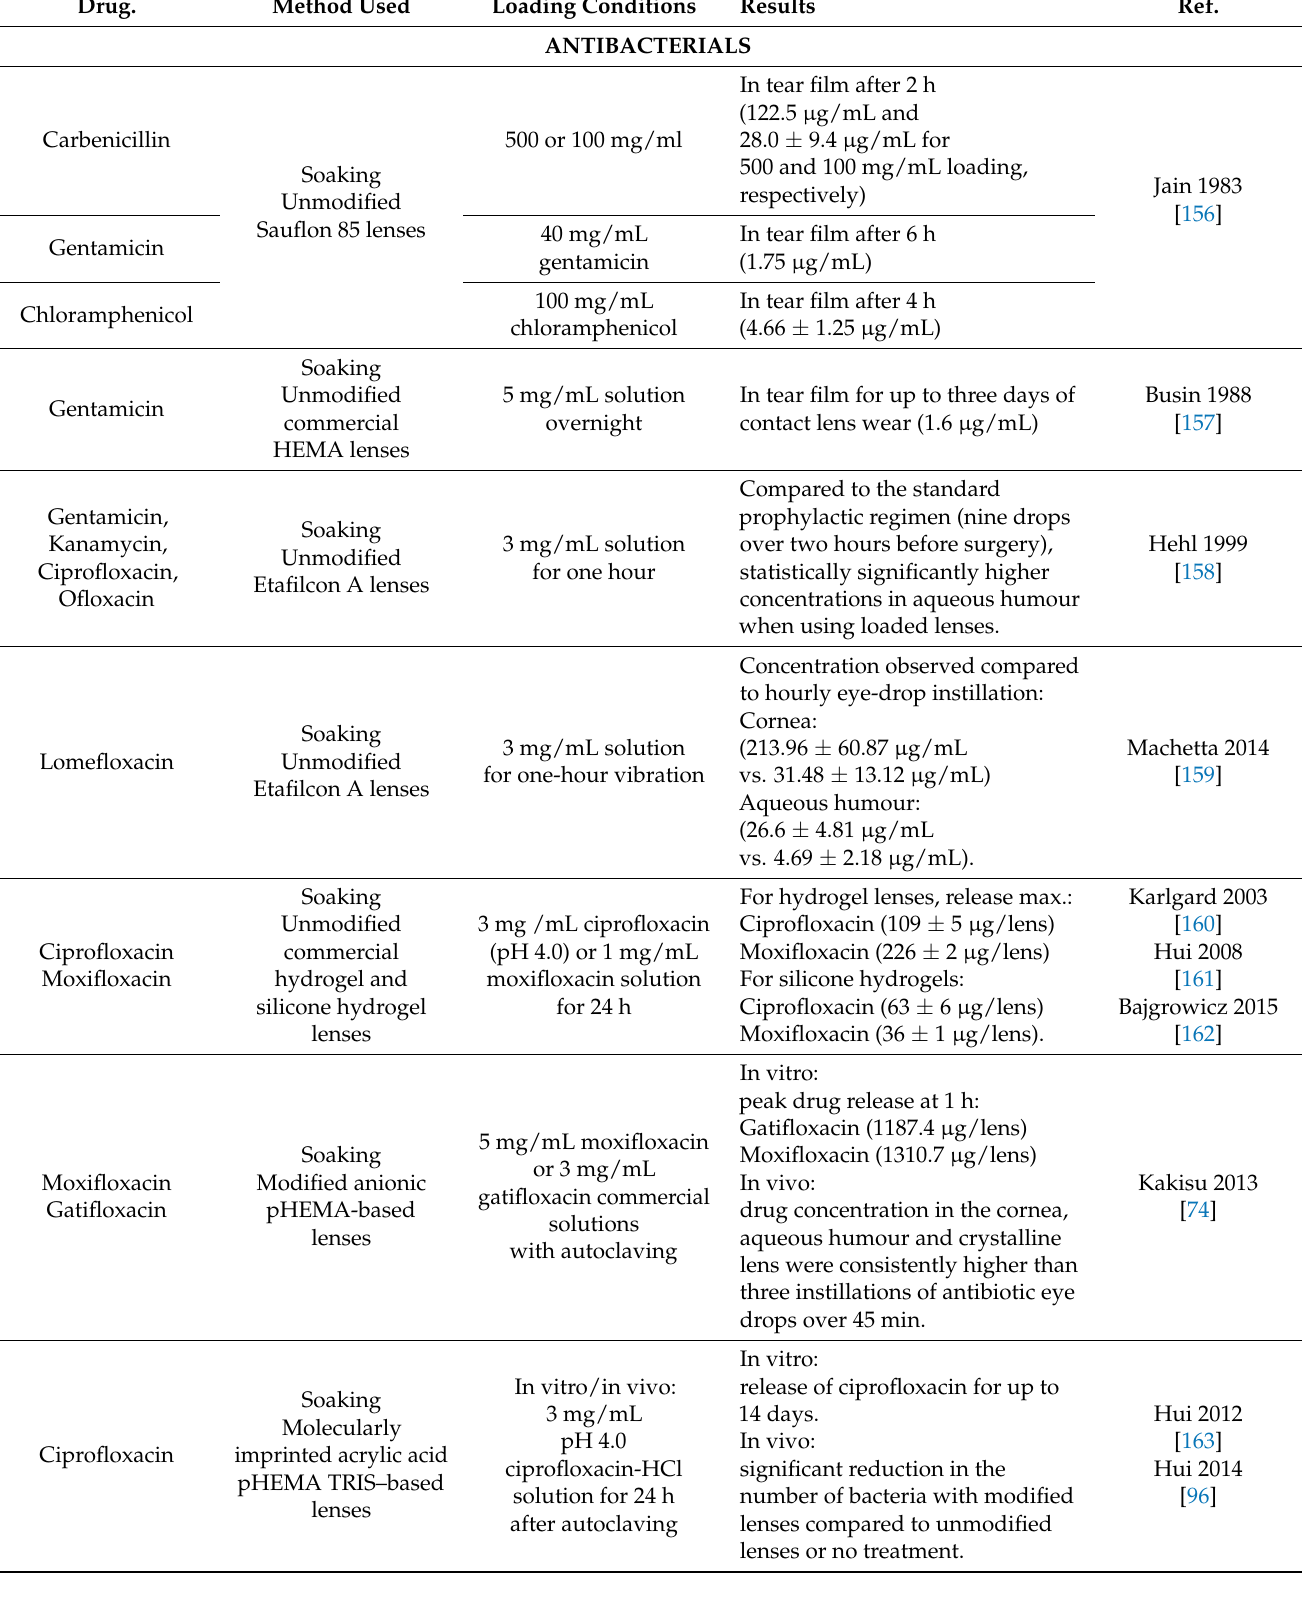
Table 3. Selected CL drug delivery experiments investigating anti-infective agents [16,155].